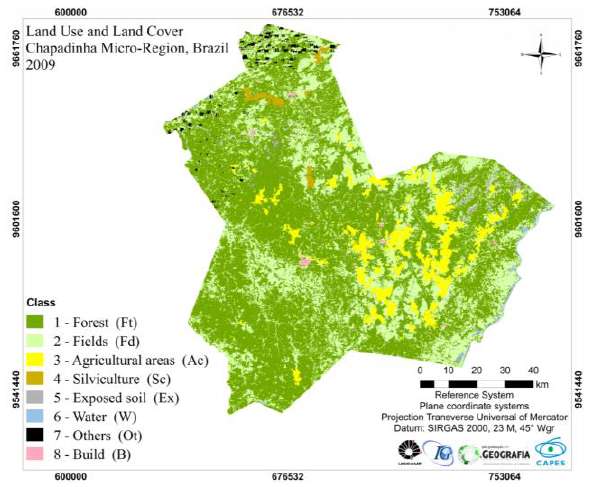
Figure 4. Land use and land cover map of the Chapadinha microregion (year: 2009).